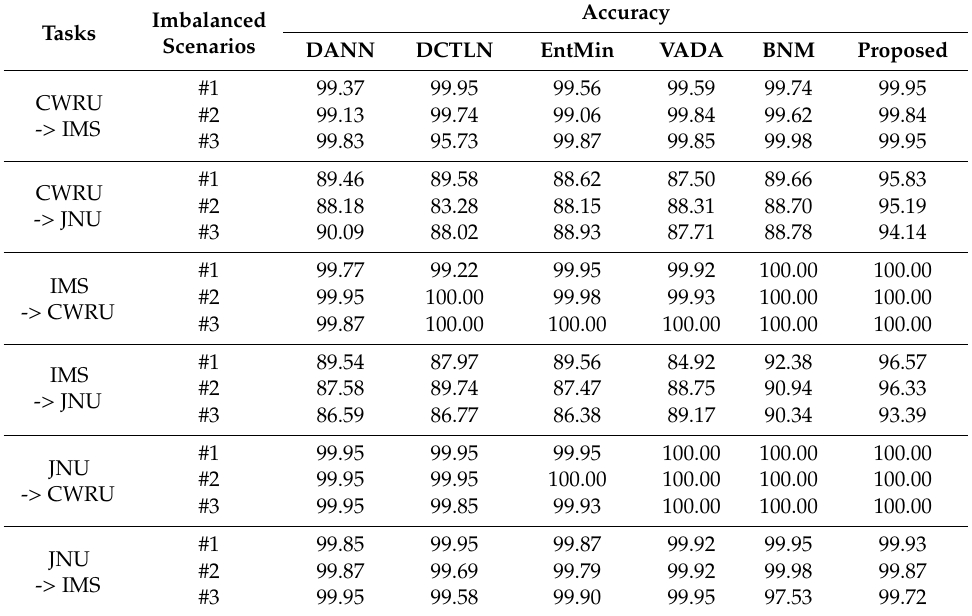
Table 6. Results of diagnosis accuracy under imbalance scenarios. The number of labeled target samples each class is fixed to